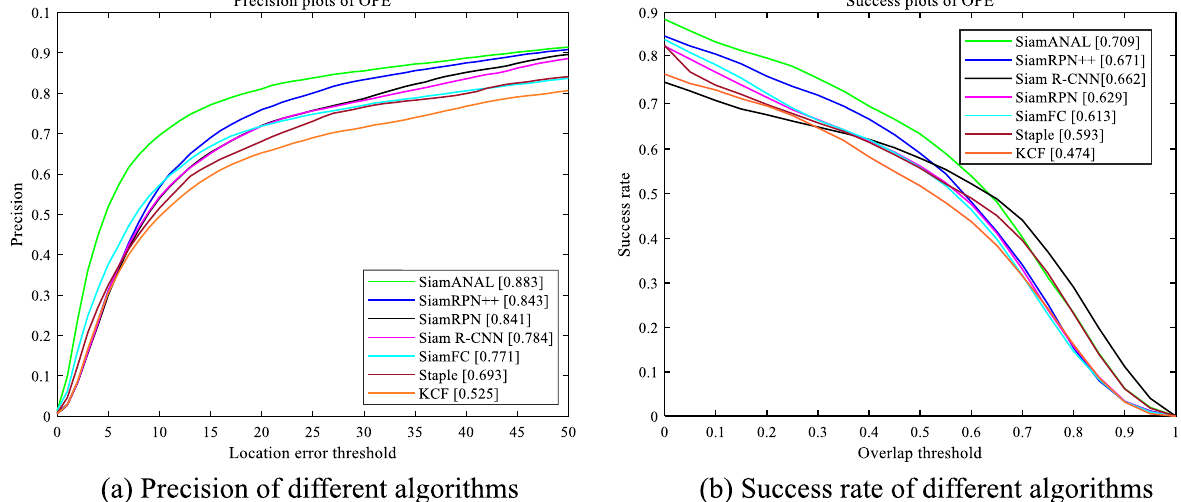
Fig. 7 Comparison of success rate and precision on OTB100. a Precision of different algorithms. b Success rate of different